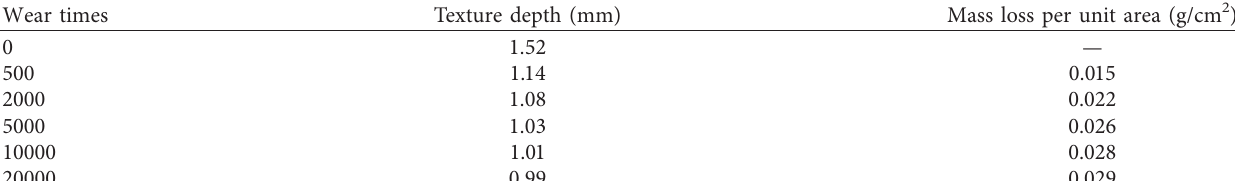
Table 7: Test results of antiwearing durability.